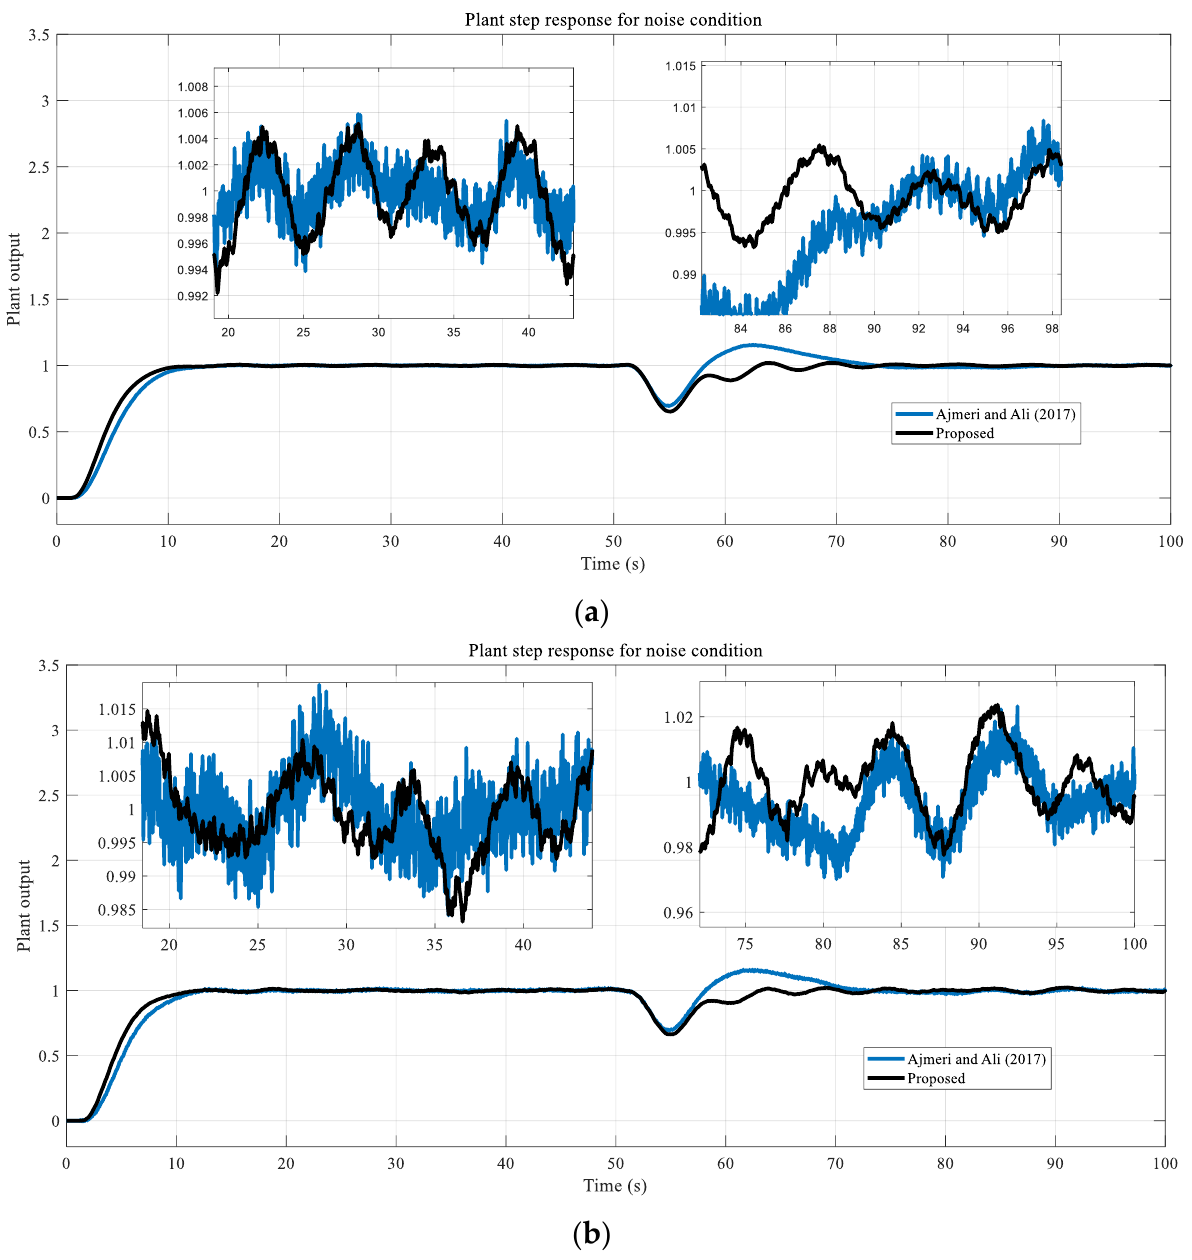
Figure 12. Performance comparison of the proposed method, in terms of noise effects, for Example 2. ( a ) Test result for noise Signal 1 and ( b ) test result for noise Signal 2 [18].